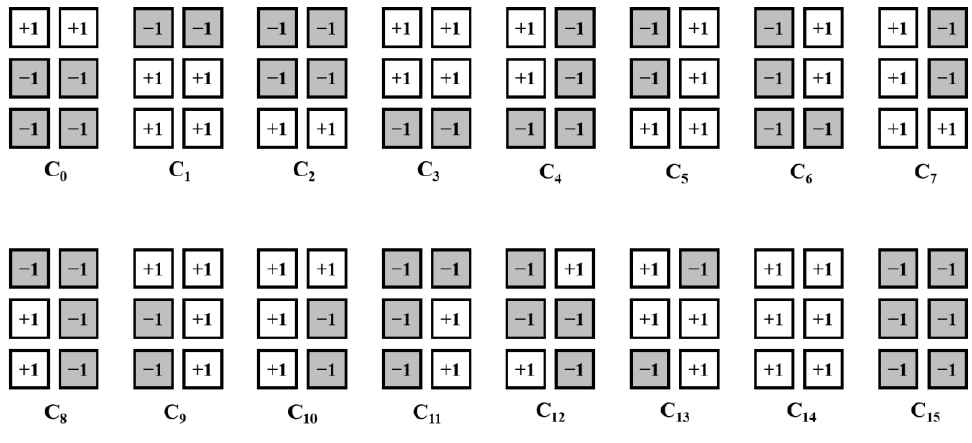
Figure 2. Codeword list of the 4/6 modulation code.